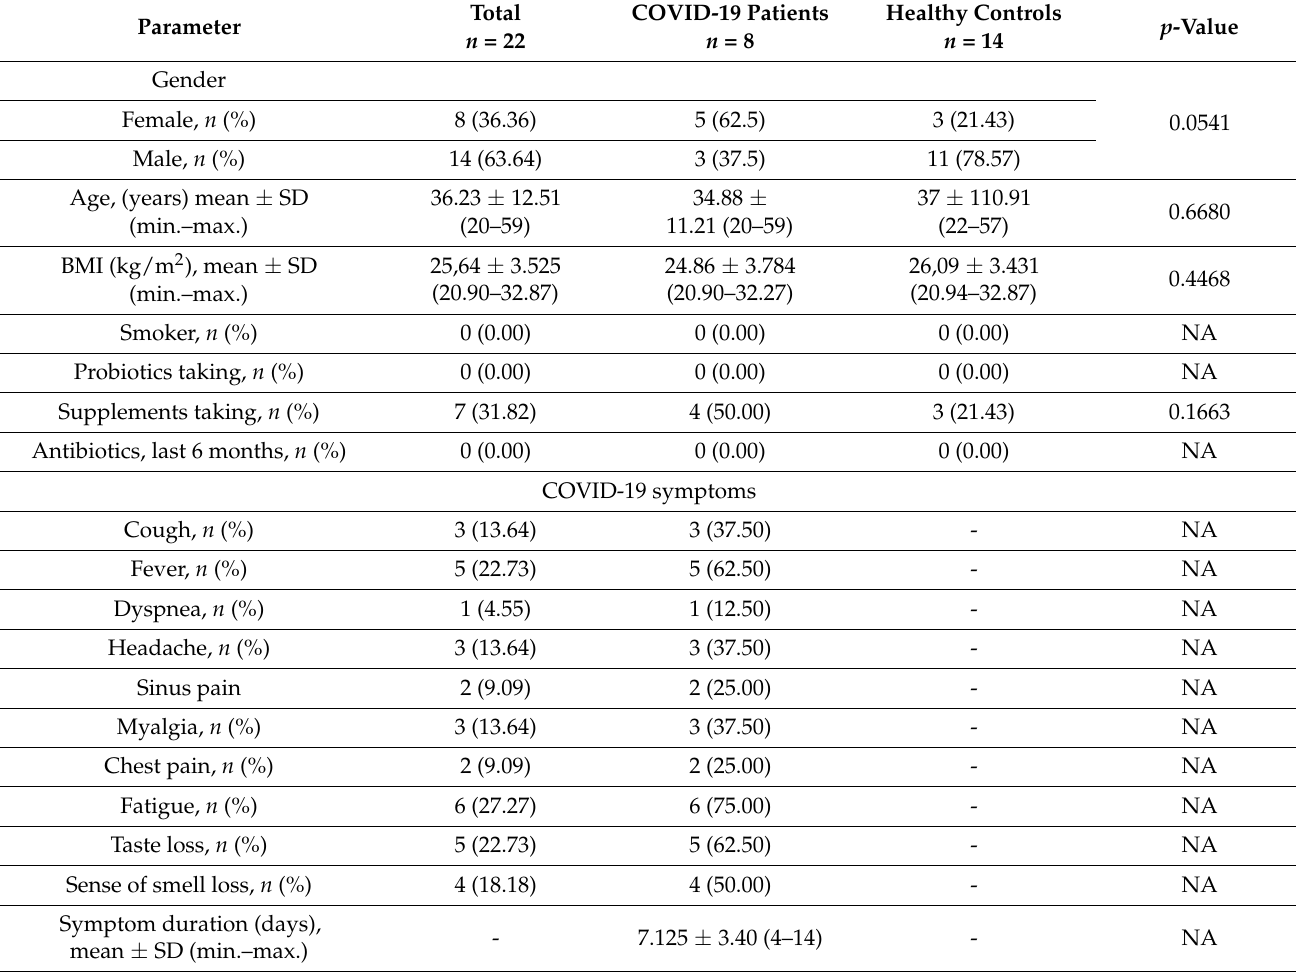
Table 1. Demographic and clinical data of the study